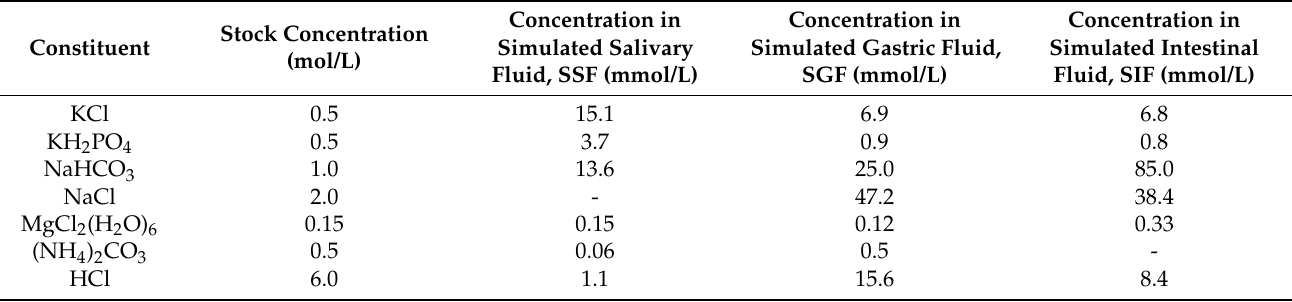
Table 1. Concentration of stock solutions of simulated digestion